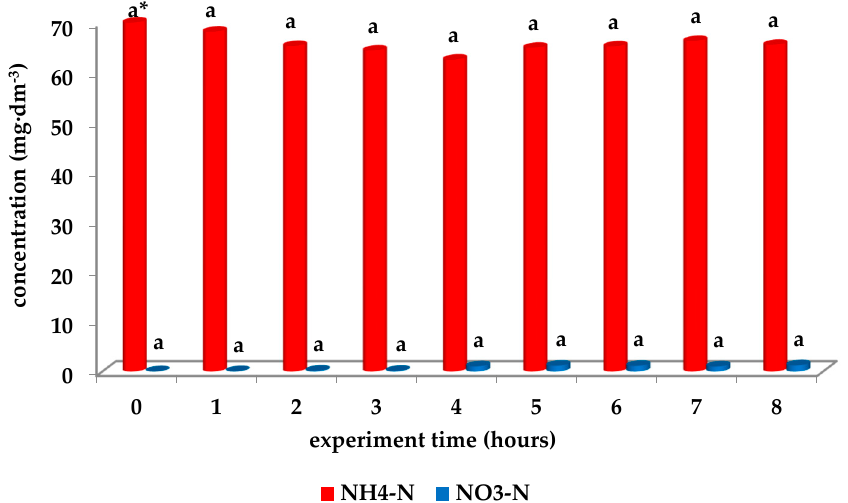
Figure 4. Removal of TAN at a concentration of 70.00 mg ∙ dm − 3 by the activated sludge meth ‐ od—control tests under dynamic conditions; *averages marked with the same letters are not sig ‐ nificantly different by Tukey test ( α = 0.05) (one ‐ way ANOVA, separately for concentration of NH 4 ‐ N and NO 3 ‐ N).